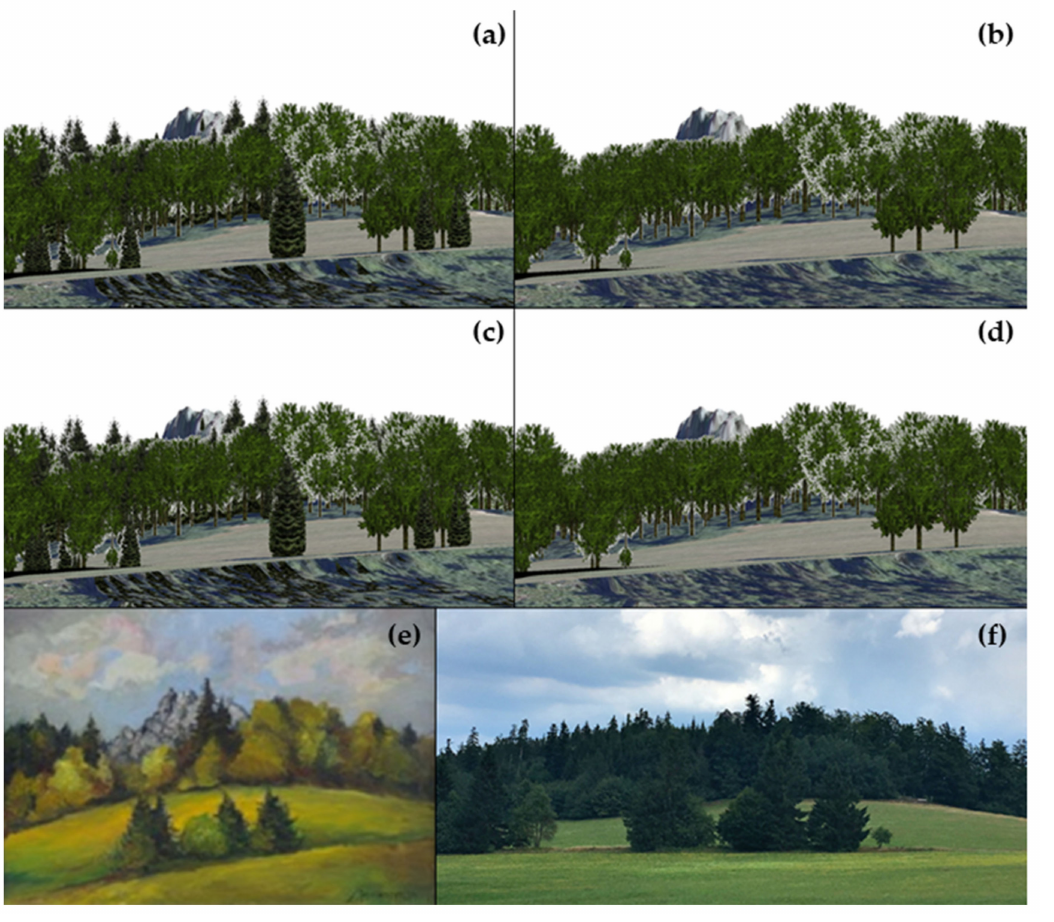
Figure 10. 3D (three-dimensional) models of forests around Dr á tenick á sk á la based on the orthophoto and NDVI classification results—tree type and position: ( a ) orthophoto—current situation, ( b ) orthophoto—potential situation after bark beetle infestation, ( c ) NDVI—current situation, ( d ) NDVI—potential situation after bark beetle infestation, ( e ) similar view in the landscape painting Dr á ten í ky u Samot í na, Milan Zimmermann, 2005, and ( f ) similar view in current photography (author: Marie Balkov á ,